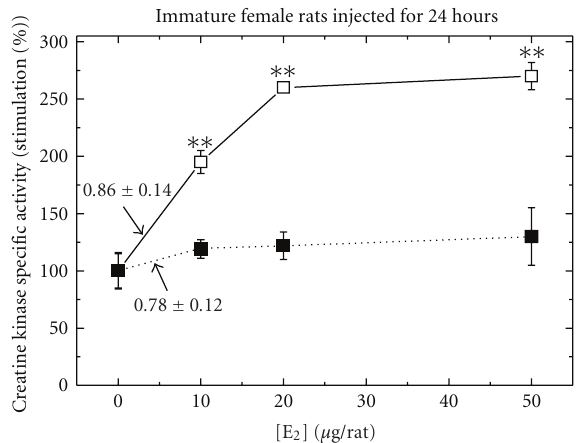
Figure 7: Dose-dependent stimulation of creatine kinase (CK) specific activity by E 2 in pituitary from immature female rats either intact (solid line) or STZ-injected animals (dotted line). Rats were treated and assayed for CK activity as described in Section 2. Results are means ± SEM for n = 5 rats/group. Experimental means compared to control means: ∗ P < . 05 and ∗∗ P < . 01. Basal activity in Pi from immature intact rat was 0 . 86 + 0 . 04, and from STZ rats was 0 . 78 + 0 . 12 μ mol/min/mg protein. Figure 8: The e ff ect of pretreatment with JKF and QW at 0.2 ng/rat